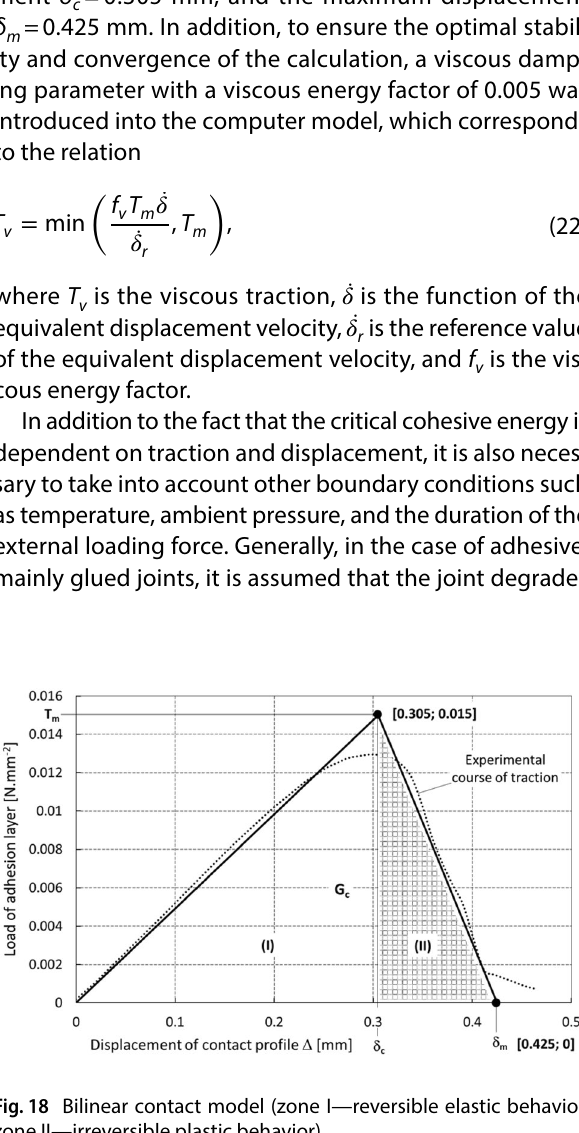
Fig. 17 Gradual relative displacement of the contact at mutual points